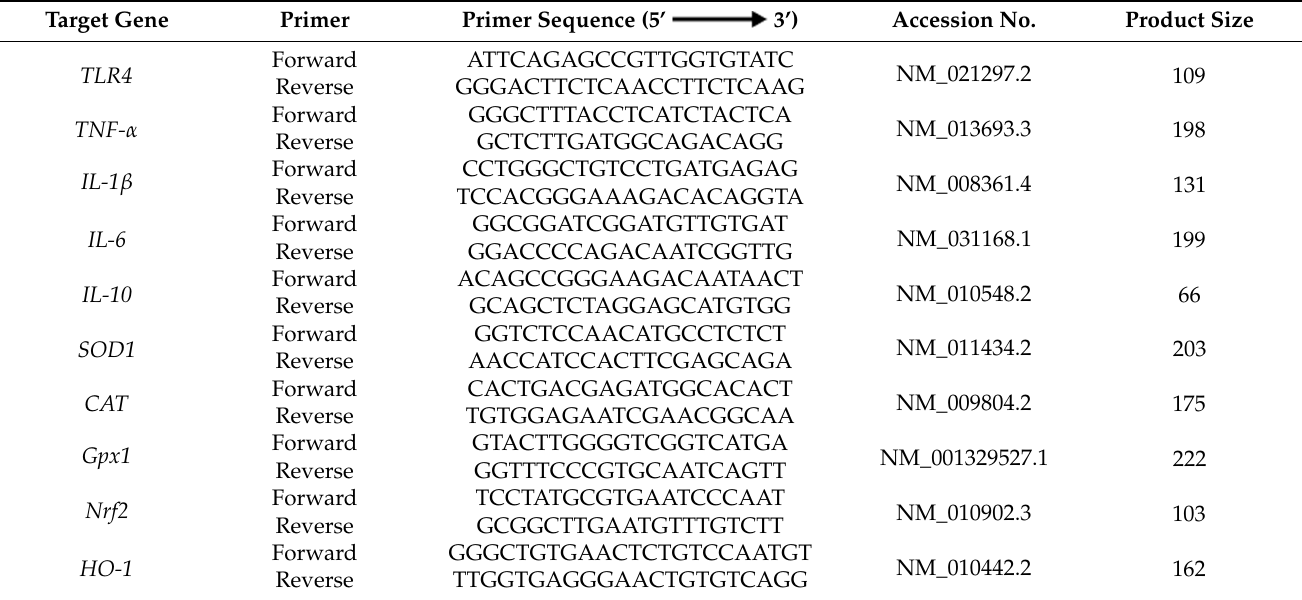
Table 3. Sequences of primers used in RT-qPCR.